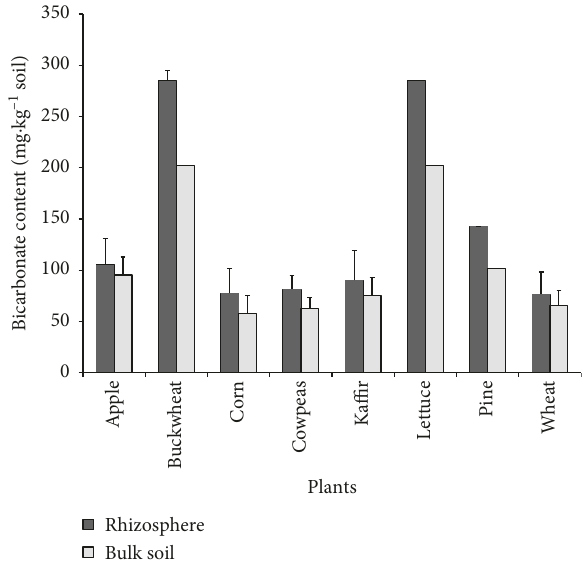
Figure 2: The compositions of bicarbonate as found in the rhi- zosphere and bulk soil of some plants grown in a greenhouse. Error bars are ± one standard deviation ( n � 2 to 34). Lettuce and pine had only data one data point each and could not be presented with error bars (data from